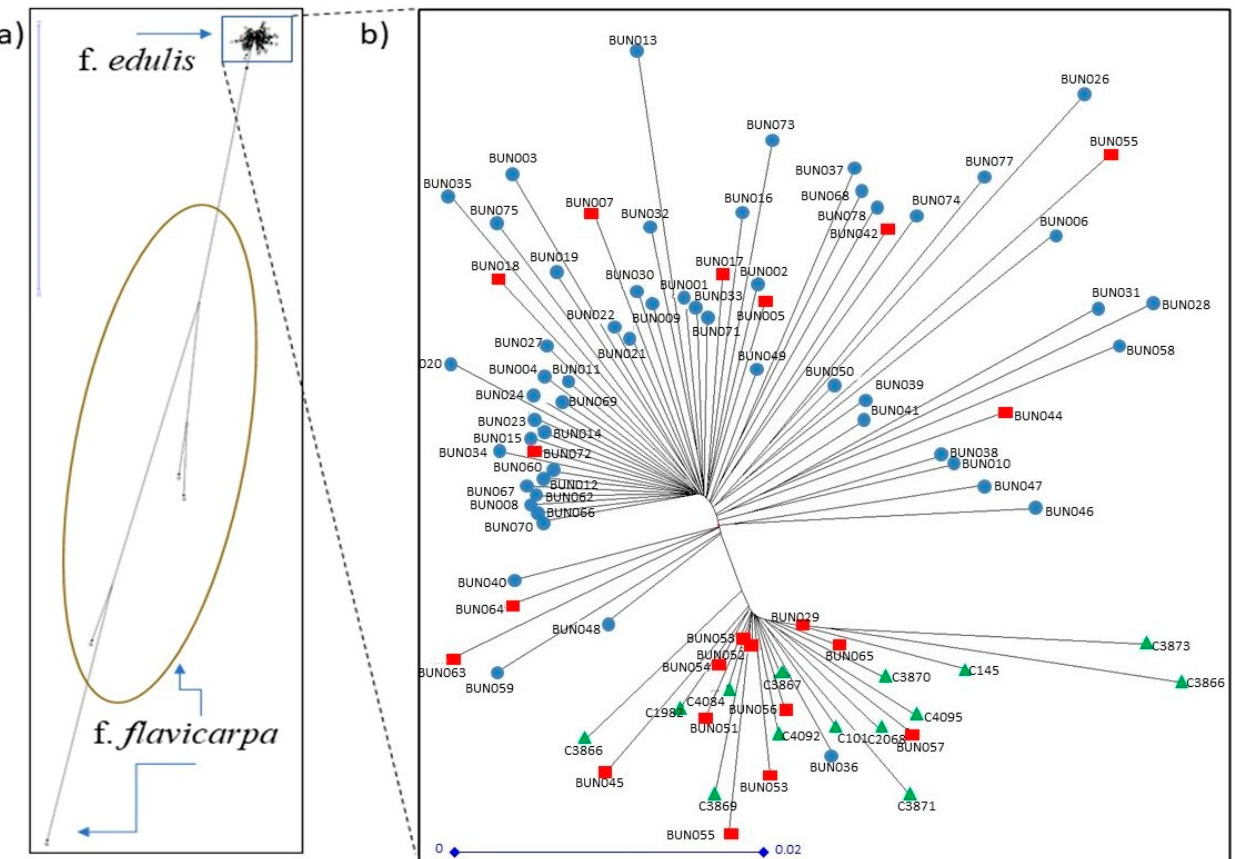
Figure 2. Dendogram of relationships in a neighbor-joining analysis between accessions of ( a ) passion fruit ( P. edulis) showing division between purple passion fruit (f. edulis ) and yellow passion fruit (f. flavicarpa ) types and ( b ) only purple passion fruits ( P. edulis f. edulis ). The latter genotypes are color coded to represent landraces in blue circles, commercial cultivars in red squares, and genebank accessions in green triangles.